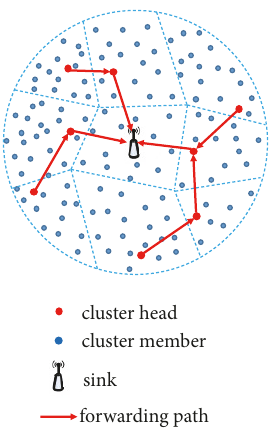
Figure 3: The network topology in the HEED based algorithms, where the CHs collect the data from the CMs and then transmit it to the